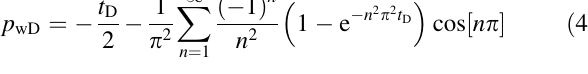
Fig. 1 A log–log plot of the solutions to the diffusivity equation in one dimension for a no-flow outer boundary condition. The dashed line represents the constant rate inner boundary condition, and the solid line represents the constant pressure inner boundary